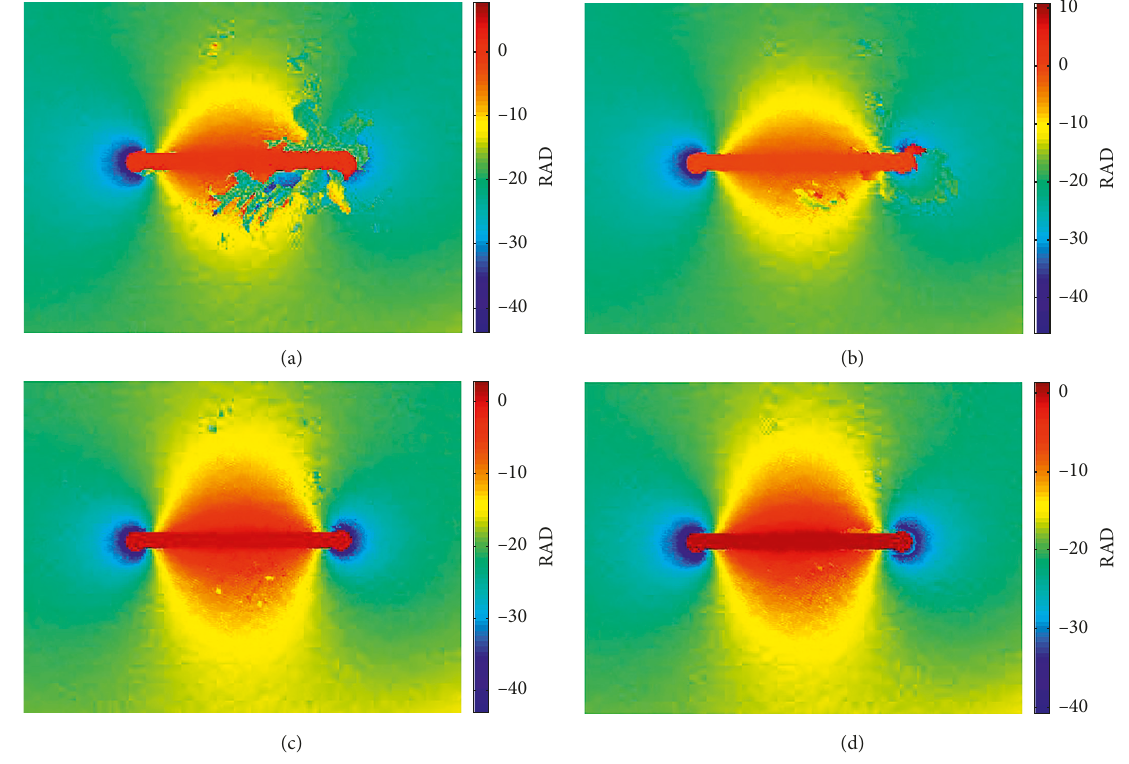
Figure 5: The unwrapped phase of the object wave as σ 00 (cid:29) 2MPa obtained from (a) Gold, (b) Quality, (c) Flynn, and (d)